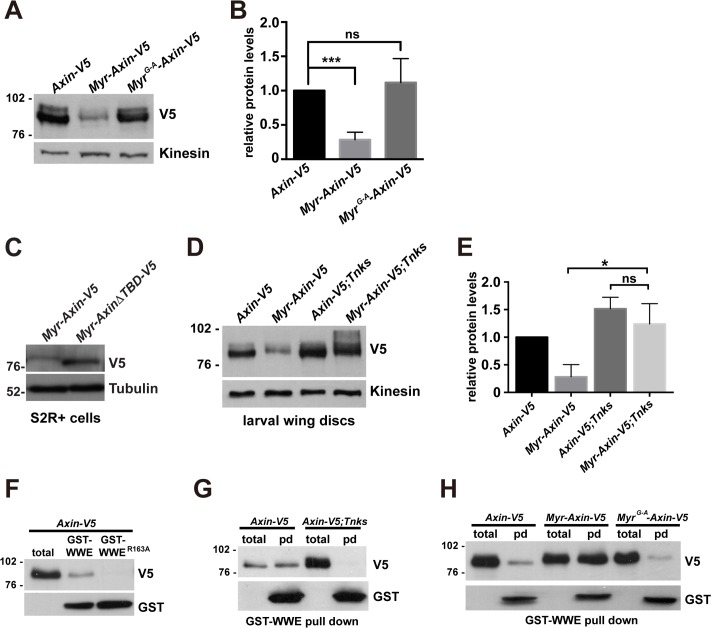
Membrane-association promotes Axin degradation through Tankyrase-dependent ADP-ribosylation(A) Lysates from third instar larvae expressing indicated transgenes with the C765-Gal4 driver were analyzed by immunoblotting. Myr-Axin-V5 is present at much lower levels than Axin-V5 or MyrG-A-Axin-V5. Kinesin was used as a loading control. (B) Quantification of the relative levels of indicated proteins. Results were obtained from four independent experiments with representative blot shown in (A). Values indicate mean ± SD. *** p<0.001, ns: not significant (t-test). (C) S2R+ cells were transfected with the indicated plasmids. Lysates were analyzed by SDS-PAGE. Immunoblotting with V5 antibody revealed that Myr-AxinΔTBD-V5 is present at higher levels than Myr-Axin-V5. Tubulin was used as a loading control. (D) Lysates from third instar larvae of indicated genotypes were analyzed by immunoblotting. Transgene was expressed with the C765-Gal4 driver. Eliminating Tnks restores the protein levels of Myr-Axin-V5. Kinesin was used as a loading control. (E) Quantification of the relative protein levels of Axin-V5 or Myr-Axin-V5 from lysates of third instar larvae of indicated genotype. Results were obtained from three independent experiments with a representative blot shown in (D). Values indicate mean ± SD. * p = 0.0163, ns: not significant (t-test). (F) Use of GST-WWE pull-down assay for detection of ADP-ribosylated Axin. Lysates from third instar larvae expressing Axin-V5 with the C765-Gal4 driver were incubated with GST-WWE or GST-WWER163A beads. Axin-V5 is pulled down by GST-WWE, but not GST-WWER163A, suggesting this assay specifically detects ADP-ribosylated Axin. (G) GST-WWE pulldown from lysates of third instar larvae expressing indicated transgene with the C765-Gal4 driver. ADP-ribosylation of Axin is abolished in Tnks19 null mutants. Total indicates total larval lysates and pd indicates samples pulled down with GST-WWE beads. (H) GST-WWE pulldown from lysates of third instar larvae of indicated genotypes. Myr-Axin-V5 is highly ADP-ribosylated by comparison with Axin-V5 or MyrG-A-Axin-V5.